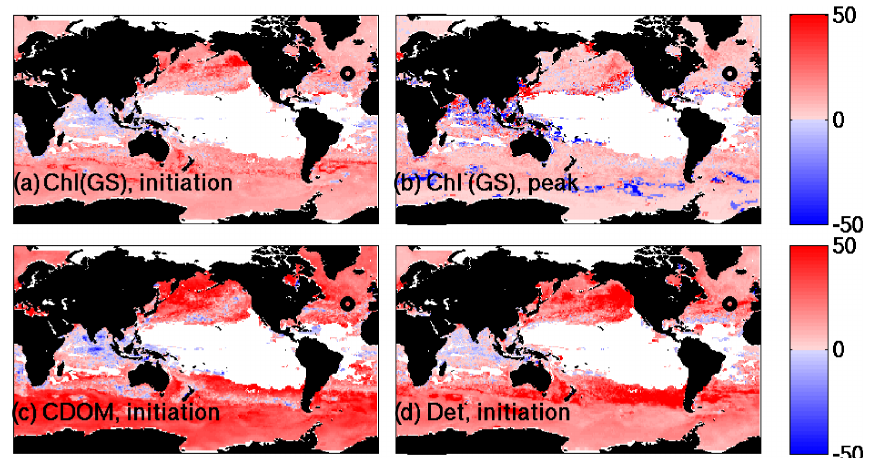
Figure 9. Global maps of the lag in phenology. Number of days between (a) the initiation of the spring bloom from model actual Chl a and that for the model derived Chl a (GS), (b) yearly maximum of model actual Chl a and that for the derived Chl a (GS), (c) initiation of the spring bloom from model actual Chl a and the initiation of the CDOM increase and (d) initiation of the spring bloom from model actual Chl a and the initiation of detrital particle increase. Bloom initiation is defined as when Chl a , CDOM or detrital particles reach 5% above their annual median value (see Appendix A). The white areas indicate regions with no significant seasonal cycle or are not resolved by the model (e.g. Arctic Ocean).